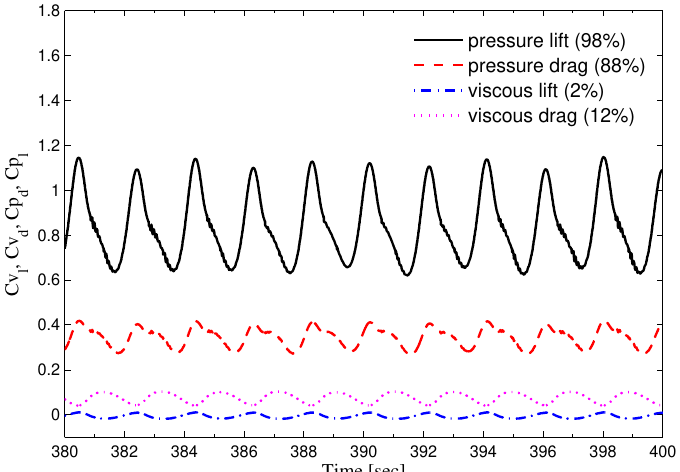
Figure 3. Time histories of the lift and drag coefficients because of the pressure and viscous stresses acting on the airfoil surface at Re =